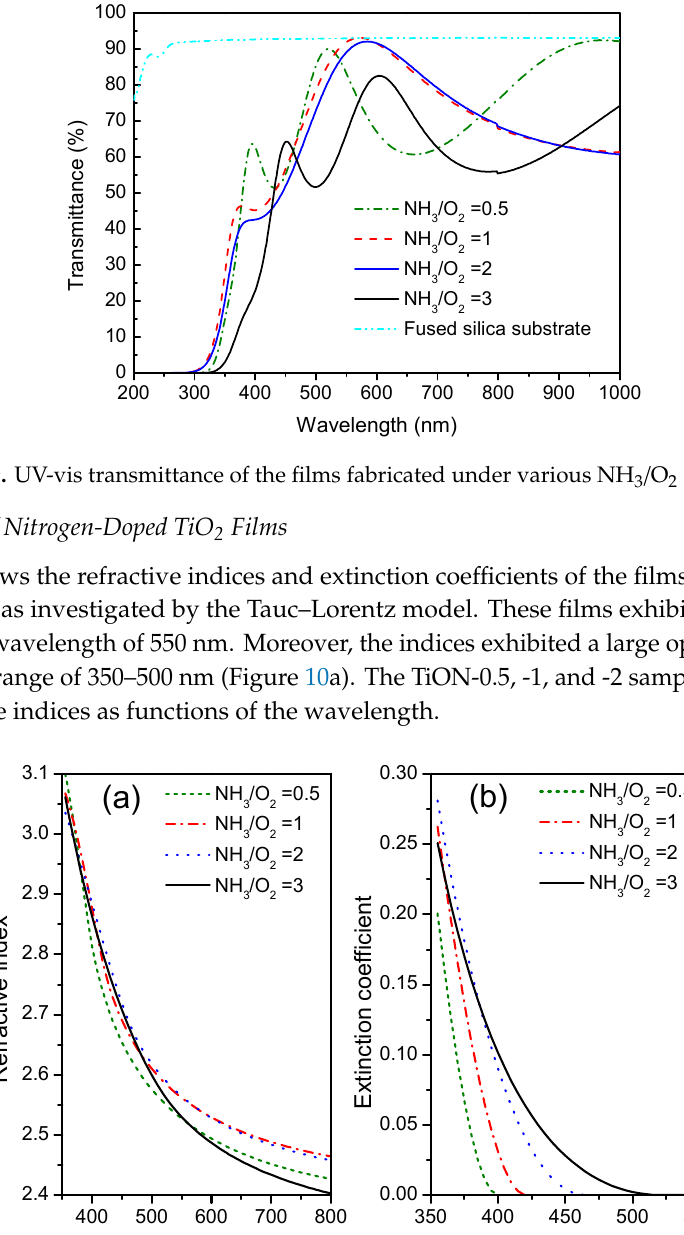
Figure 10. Refractive indices ( a ) and extinction coefficients ( b ) of the films as functions of NH 3 /O 2 gas ratio and wavelength.